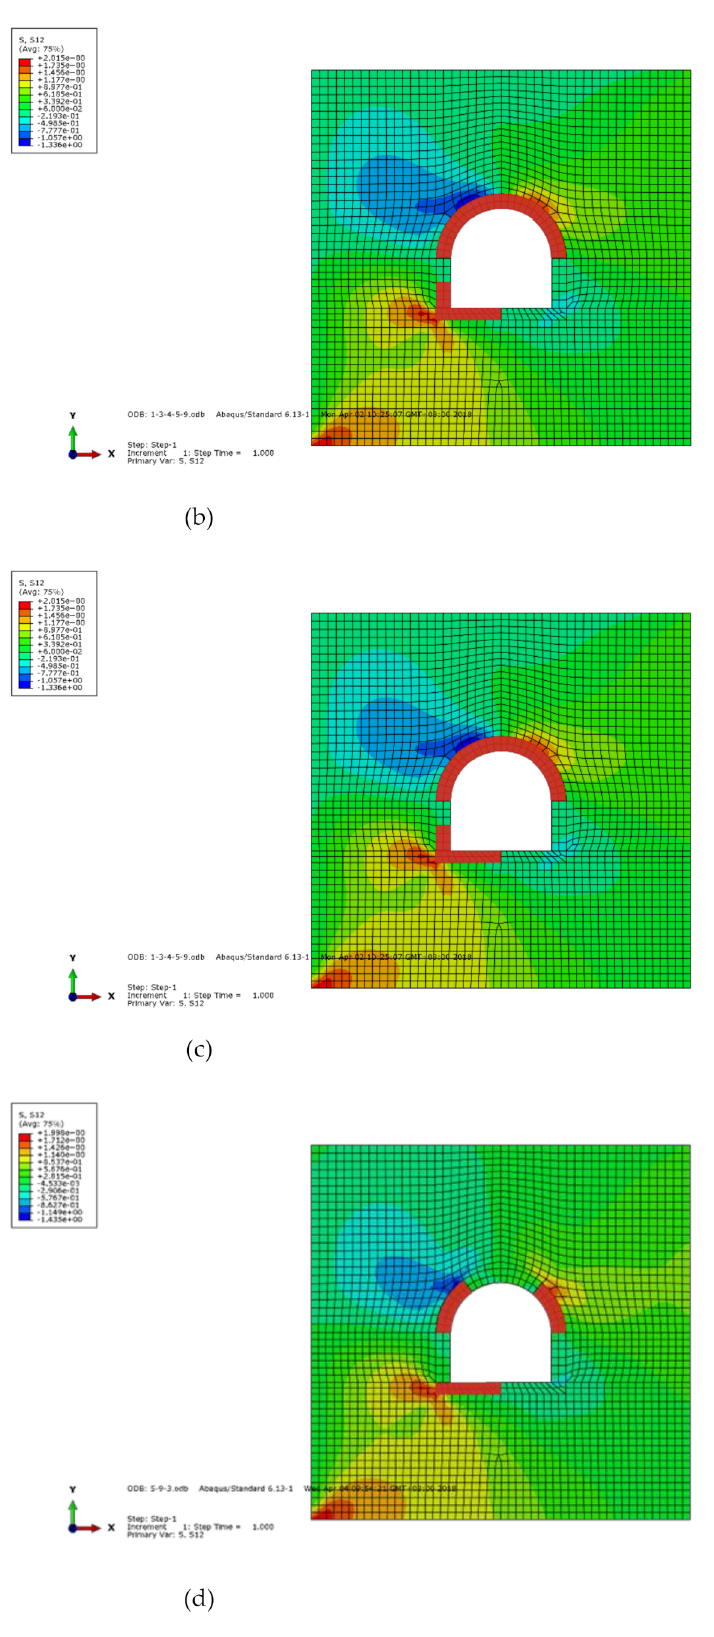
Figure 13. Final failure parts when λ = 2. ( a ) Final failure parts of group 1, ( b ) Final failure parts of group 2, ( c ) Final failure parts of group 3, ( d ) Final failure parts of group